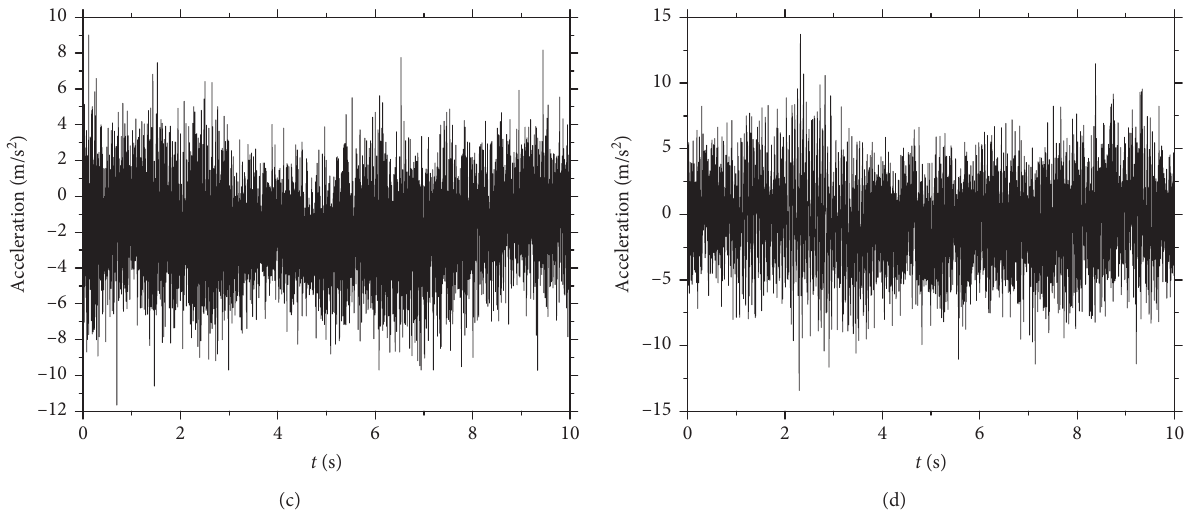
Figure 19: Plots of the measured suspension upper point acceleration versus time (at 30km/h) for the (a) front left suspension; (b) front right suspension; (c) rear left suspension; and (d) rear right suspension.